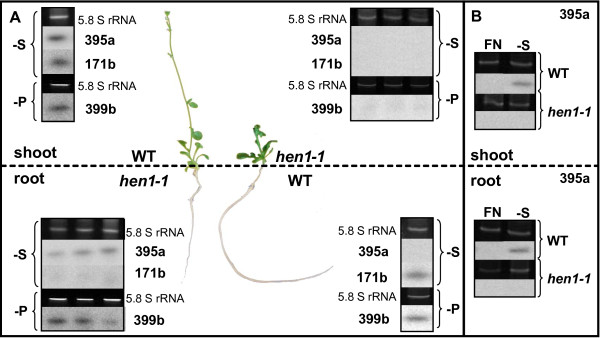
WT/hen1-1 grafting experiments. Analysis of mature miR395, miR399 and miR171 by RNA gel blot analysis in scions and rootstocks of reciprocal hen1-1/WT and WT/hen1-1 grafts under sulfate and phosphate deficiency. A: miRNAs 395 and 399 were translocated from WT scions to hen1-1 rootstocks but not in the opposite direction, miR171 was immobile. One representative result is shown for WT, and three replications for hen1-1 roots and shoots. The hen1-1 graft parts kept their growth retardation phenotype, indicating that not all necessary miRNAs could be transferred. The 5.8 ribosomal RNA band served as a loading control. B: Control of miR395 expression in WT and hen1-1 mutant plants. In WT plants miR395 was induced by sulfate deficiency in shoots and roots, while no signal was detected in hen1-1 mutants under both conditions.